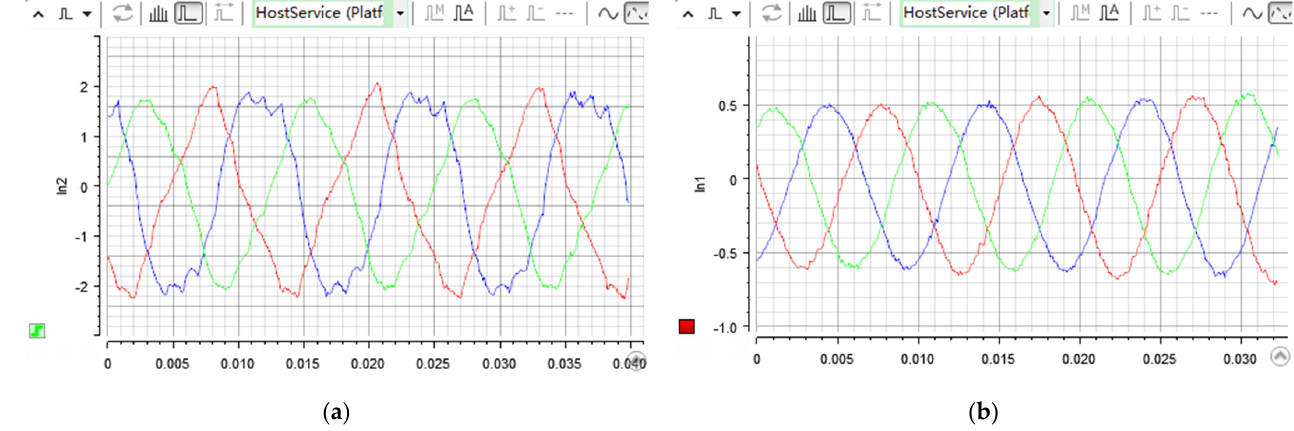
Figure 9. Testing result: the waveform of the drive current: ( a ) half-step subdivision mode in the